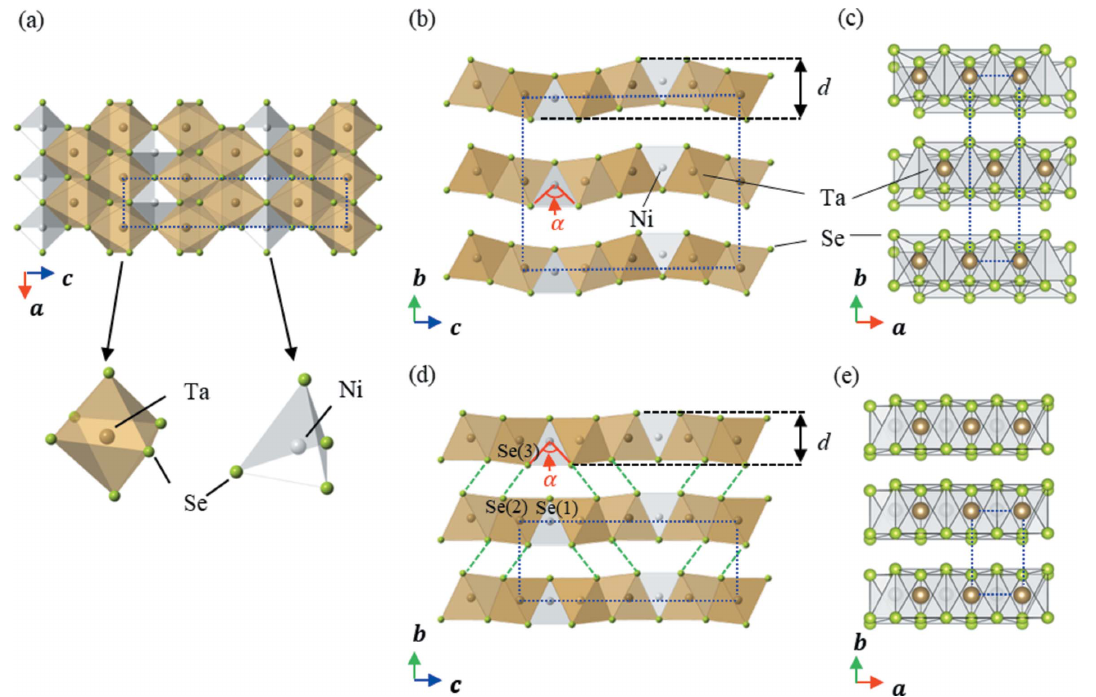
Figure 3 ( a ) The in-plane crystal structure viewed from the b axis (common to phases below and above 3 GPa). ( b ) and ( c ) The crystal structure of the phases below 3 GPa viewed from ( b ) the a axis and ( c ) the c axis. ( d ) and ( e ) The crystal structure obtained above 3 GPa viewed from ( d ) the a axis and ( e ) the c axis. The dotted blue lines indicate the unit cell for each structure at the given pressure, while (cid:7) and d indicate the Se—Ni—Se bond angle and the layer thickness, respectively. The dashed green lines represent the Se(2)–Se(3) distance (see also Fig. 5 a